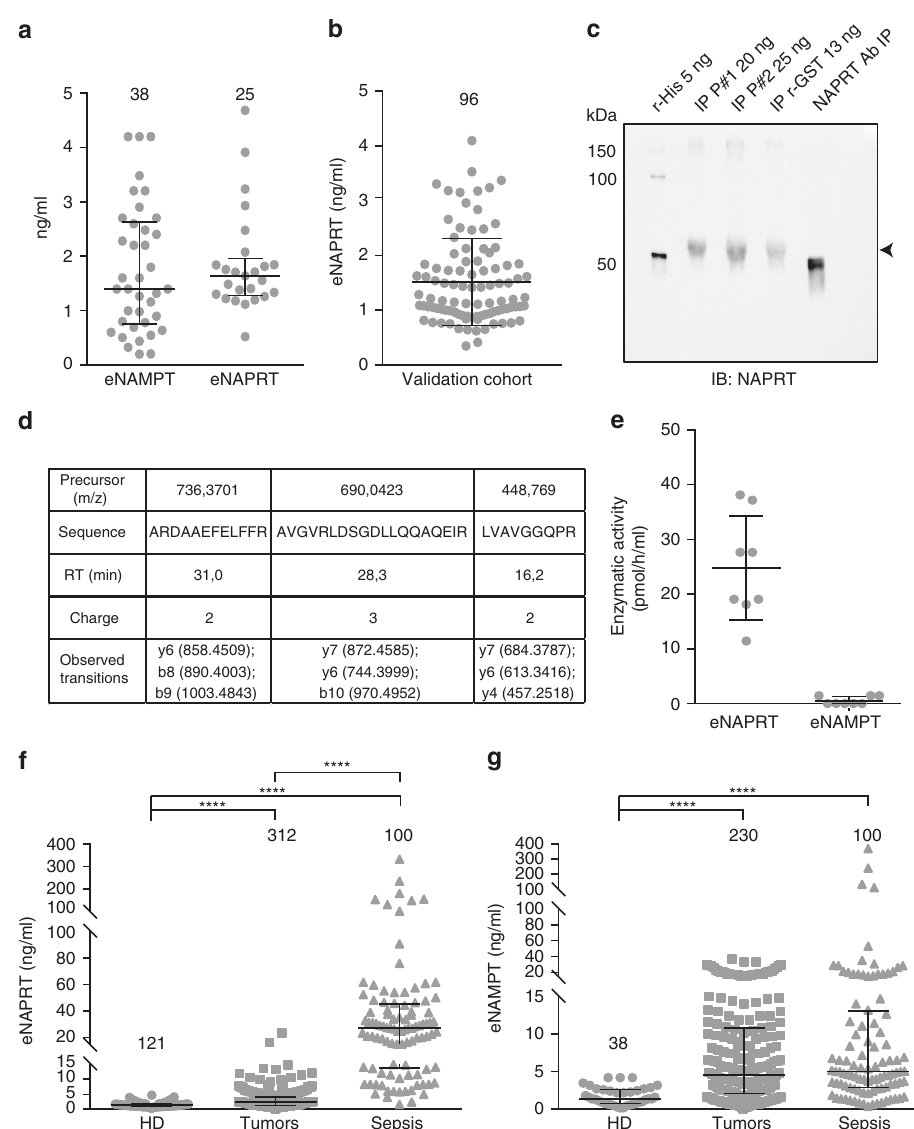
Fig. 1 eNAPRT is present in normal human plasma, increasing in septic patients. a eNAMPT and eNAPRT concentrations (ng/ml) as measured in plasma from HD. b eNAPRT concentrations (ng/ml) measured by luminex in a validation cohort of plasma from HD ( n = 96). c The presence of eNAPRT was con fi rmed by western blot performed on immunoprecipitated (IP) fractions of recombinant rNAPRT-GST-tag (MyBioSource MBS969577) and IP from NAPRT-enriched plasma of two donors (#1 – 2). rNAPRT-His-tag (home-made recombinant full-length protein) was loaded as control. The protein amount refers to eNAPRT levels measured by luminex. The primary anti-NAPRT antibody used for immunoprecipitation, loaded in the last right lane and recognized by secondary antibody, was an internal control to con fi rm that samples were not contaminated by primary antibody. d Table reporting the three proteotypic NAPRT peptides at the expected retention times (RT), identi fi ed by the observed transitions with an error within 15 ppm using a targeted proteomic approach on a pool of sera containing high levels of NAPRT. e Graph showing eNAMPT and eNAPRT enzymatic activities (pmol product/h/ml) in the plasma of HD samples, as determined by a fl uorometric assay. f , g Scatter dot plots showing eNAPRT and eNAMPT levels measured by luminex or quantitative ELISA performed on plasma/sera samples from HD (circles, n = 121 for NAPRT and n = 38 for NAMPT), tumor patients (squares, n = 312 for NAPRT and n = 230 for NAMPT) or septic patients (triangles, n = 100 for both). Mann – Whitney test. The line in the dot plot de fi nes the median and the error bars de fi ne the interquartile range. Source data are provided as a Source Data fi